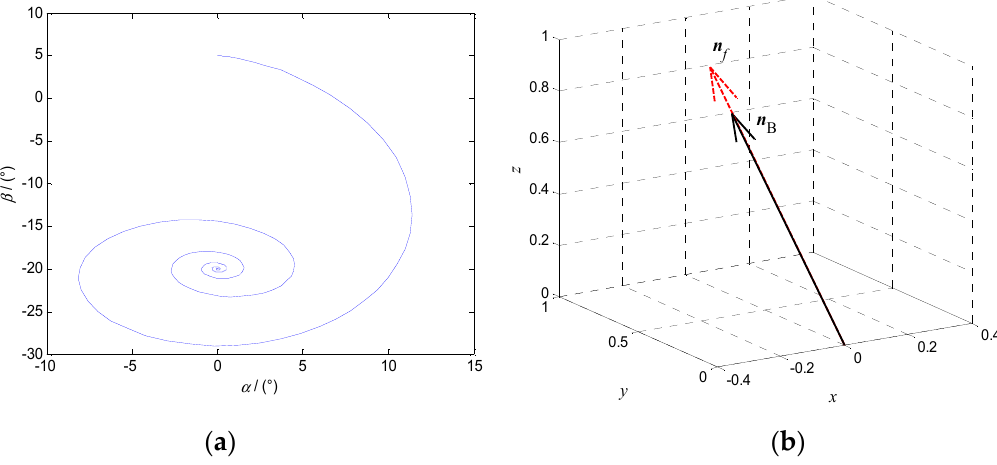
Figure 7. Asymptotically stable motion of the DSCR when ω = 18 π rad/s, B = 7 mT, l = 0 mm. ( a ) The system phase diagram; ( b ) The orientation relationship between n f and n B .